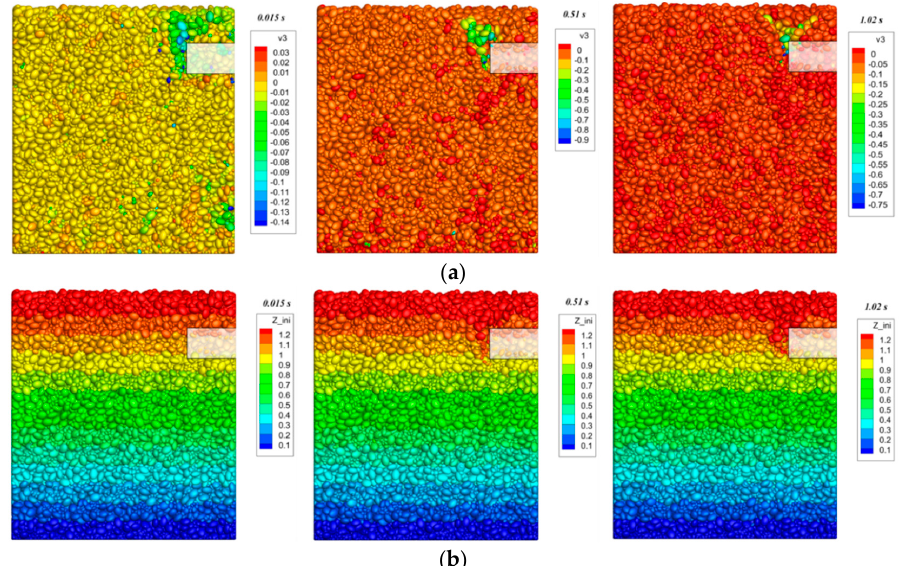
Figure 14. The collapse of tunnel face ( C / D = 1.0): ( a ) Speed distribution of particles (vertical direction, unit: m/s); and ( b ) displacement distribution of particles (vertical direction, unit: m).